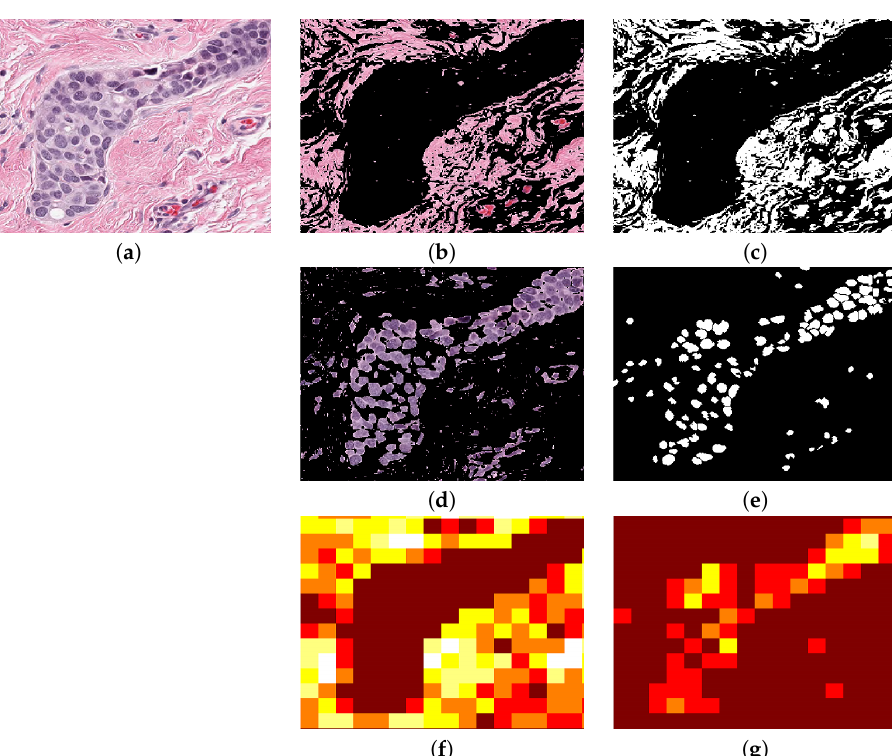
Figure 5. Regional analysis of the data. ( a ) Original image. ( b ) Ip , stroma region image obtained from colour separation. ( c ) Binarised Ip image. ( d ) Ib nuclei image obtained from colour separation. ( e ) Binarised Ib image. ( f ) Regional image concentration of Ip in which brown colour indicates the lowest and white is the highest region concentration. ( g ) Regional density concentration of Ib . This example was processed at 30 × 30 pixels window.